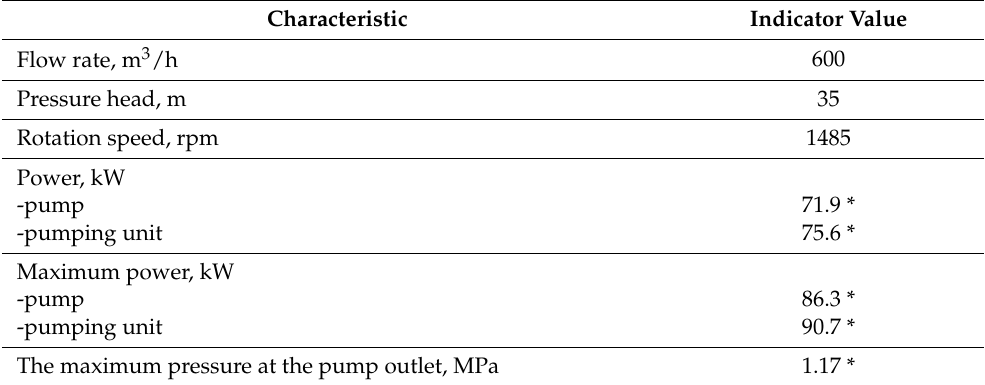
Table 1. Operating parameters of the developed pump ACNA